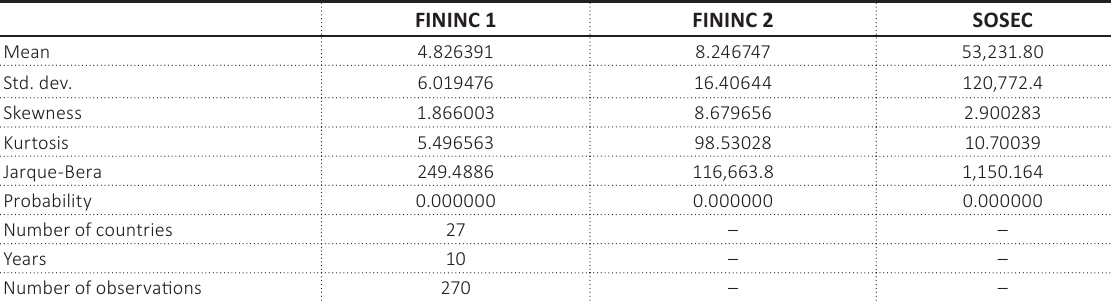
Table 2. Statistics from 2007 to 2017 in their raw value